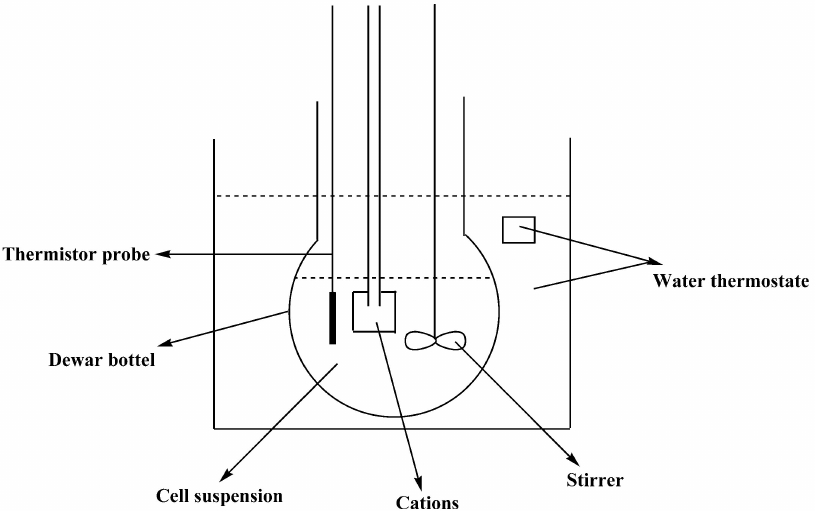
Figure 2. Schematic diagram of the isoperibol calorimeter used for adsorption heat